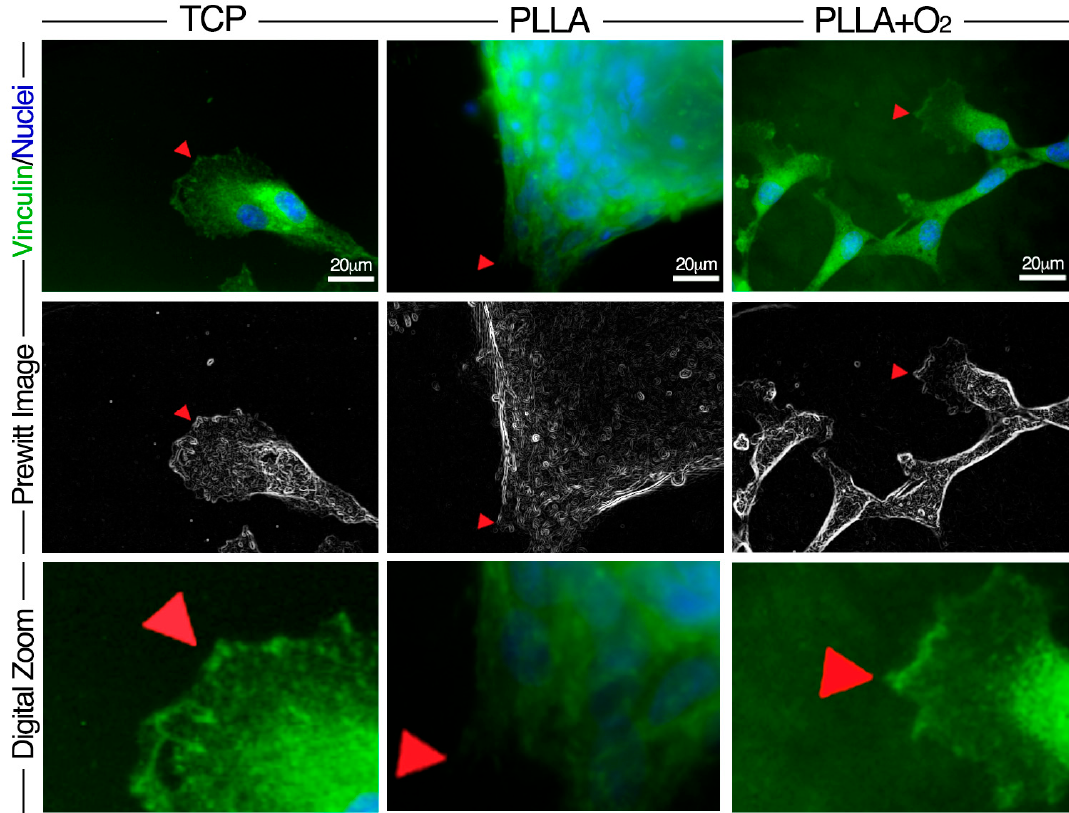
Figure 5. Distribution of Vinculin Focal Adhesion Spots in hASCs on PLLA and on PLLA+O 2 . Immunofluorescence representative images show the expression of Vinculin (green) and VFASs (red arrow) and the related Prewitt images elaboration by MATLAB software. Image magnification: 60×. Digital zoom 3× from the original 60× images.